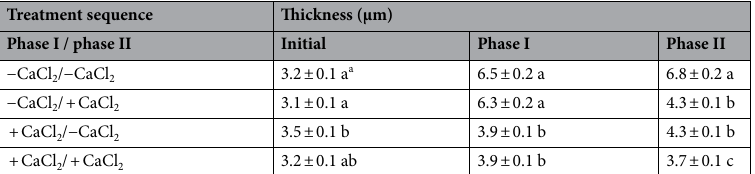
Table 4. Effects of CaCl 2 on thickness of anticlinal epidermal cell walls of excised skin segments (ES) of ʻ Burlat ʼ sweet cherry fruit. The experiment was conducted by imposing sequential treatments on the same specimen. First, initial thickness of the cell walls was measured and then the turgor was released by a freeze/ thaw cycle. The experiment then continued with two phases. The sequences of treatments (phase I / phase II) were −CaCl 2 /−CaCl 2 , −CaCl 2 / + CaCl 2 , + CaCl 2 /−CaCl 2 , + CaCl 2 / + CaCl 2 . The durations of phase I and phase II were both 48 h. At the ends of both phases, cell wall thickness was again measured. The concentrations of CaCl 2 were all 10 mM. All solutions were buffered with 10 mM MES and pH adjusted with KOH to pH 5.8. Data are means ± SE. a Mean separation within columns, Tukey’s Studentized range test at p < 0.05.